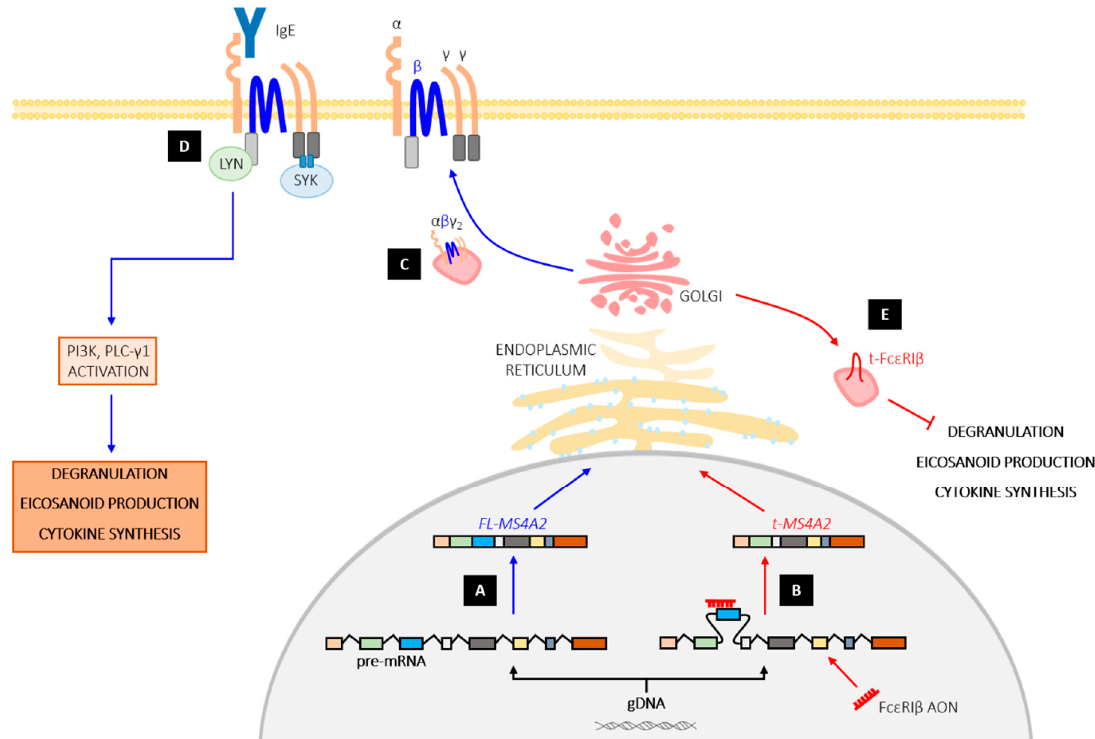
Figure 3. The functional effect of Fc ε RI β antisense oligonucleotide (AON) treatment on mast cell activation. Blue arrows represent the path of full-length (FL) MS4A2 and Fc ε RI β ; red arrows represent the path of truncated (t)-MS4A2 and t-Fc ε RI β , as a consequence of Fc ε RI β exon skipping by Fc ε RI β AONs. ( A ) MS4A2 pre-mRNA molecule undergoes normal splicing, resulting in transcription of FL-MS4A2 and translation of Fc ε RI β . ( B ) In the presence of Fc ε RI β AONs, exon 3 of MS4A2 pre-mRNA molecule is alternatively spliced, resulting in a truncated mature mRNA molecule, t-MS4A2. ( C ) FL-Fc ε RI β forms complex with α and γ -subunits and traffics the receptor complex to the cell surface. ( D ) At the cell surface, FL-Fc ε RI β stabilizes the receptor, enabling activation of Fc ε RI by antigen via crosslinking IgE antibodies, and subsequent proinflammatory cellular outcomes. ( E ) In contrast, t-MS4A2 is translated into t-Fc ε RI β that lacks the first two transmembrane regions, rendering it incapable of trafficking Fc ε RI α to the plasma